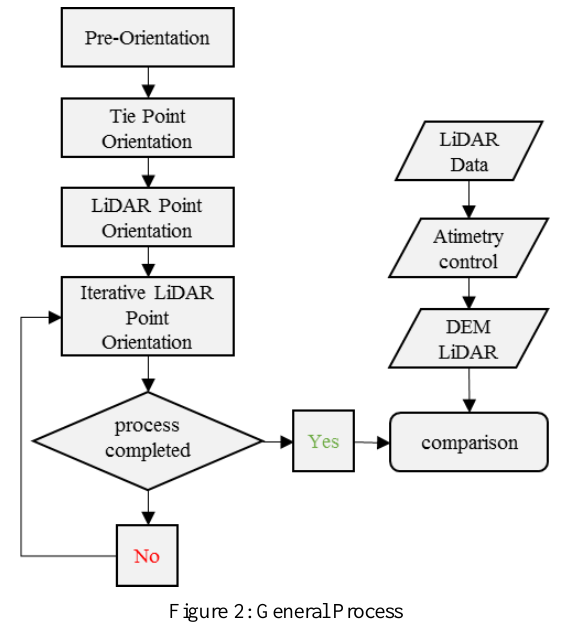
Figure 2: General